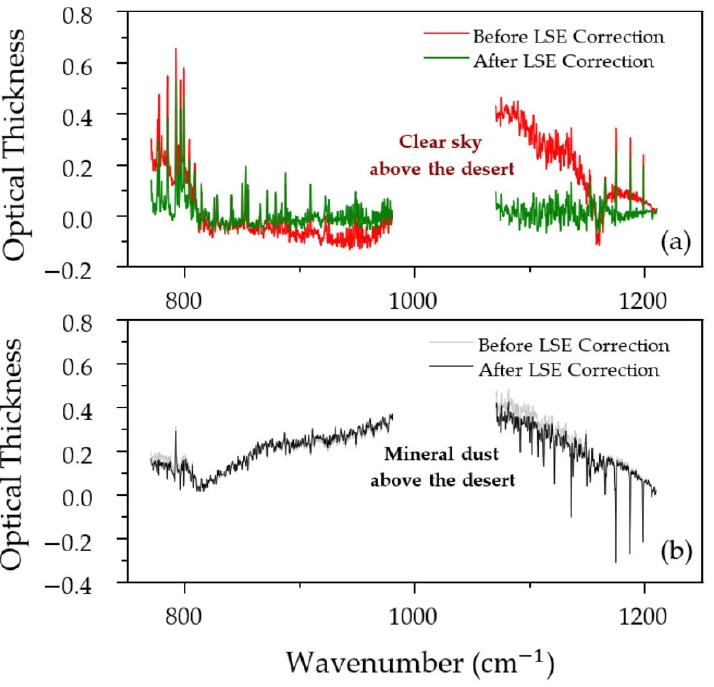
Figure 7. Example optical thickness spectra of ( a ) a clear sky above the desert and ( b ) mineral dust above the desert before and after LSE correction.